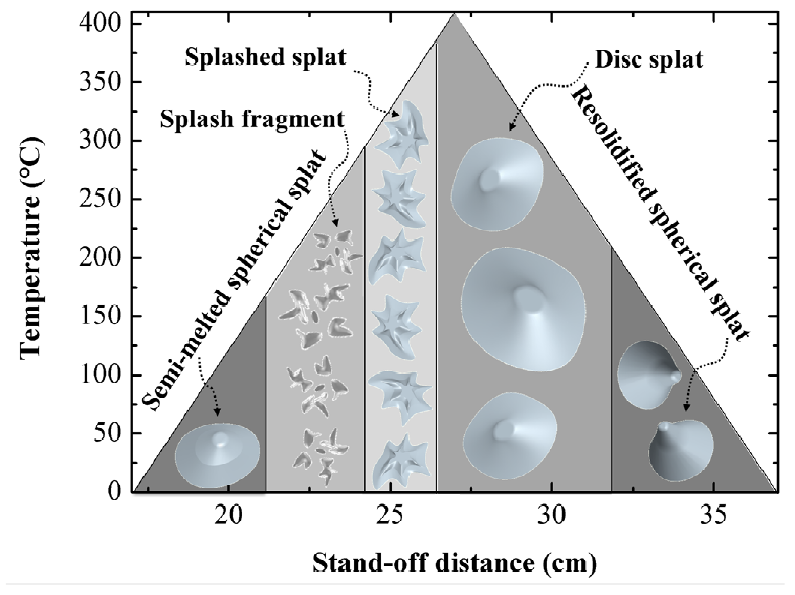
Figure 15. Velocity–Stand-off (VS) map of EMAA single